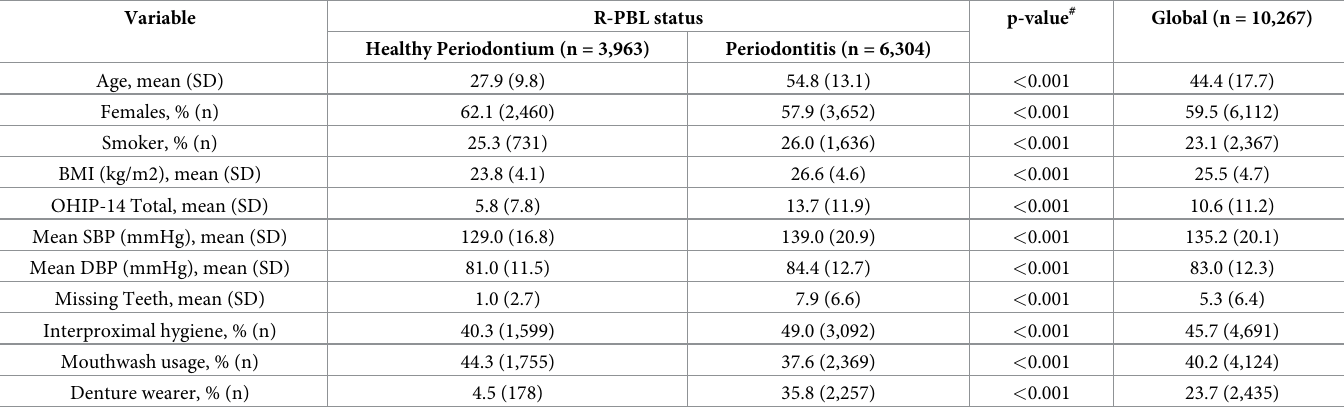
Table 1. Characteristics of participants according to the R-PBL assessment (n =